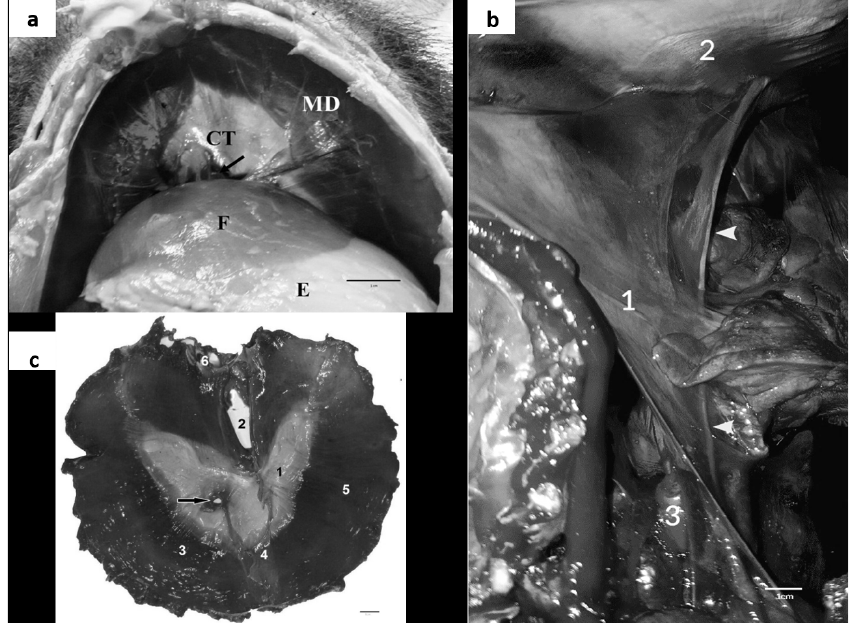
Figure 2 - Photomacrography of the diaphragm muscle of the Southern Tamandua ( in situ ). a: Caudal portion highlighting the tendinous centre (CT). We can note the concave formation of the muscle of the diaphragm (MD) and organs of the abdominal cavity, like the liver (F) and stomach (E). Next to the tendinous centre, we can observe the caudal vena cava crossing the foramen of the caudal vena cava (arrow). Scale bar: 1 cm. b: Photomacrography of the diaphragm muscle of the Southern Tamandua ( ex situ ). Presence of the mediastinal pleura (1), diaphragm (2), aorta (3) and phrenic nerve (arrow). Scale bar: 1 cm. c: Abdominal portion of the diaphragm muscle of the Southern Tamandua. Tendinous centre (1), esophageal hiatus (2), right coastal portion (3), sternal part (4) of the diaphragmatic dome, left costal portion (5), aortic hiatus (6), foramen of the caudal vena cava (arrow). Scale bar: 1